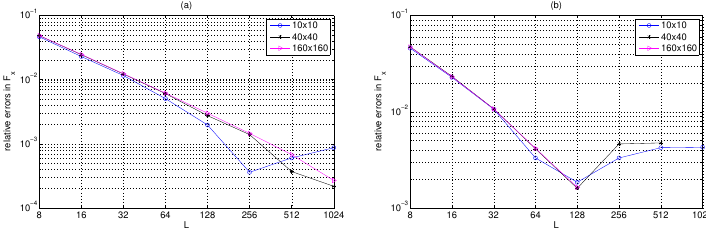
Figure 13. Tangential contact problem: errors in tangential force F x , with ICs by a piecewise constant load on (a) hexahedron Mesh1 and on (b) prismatic Mesh2.